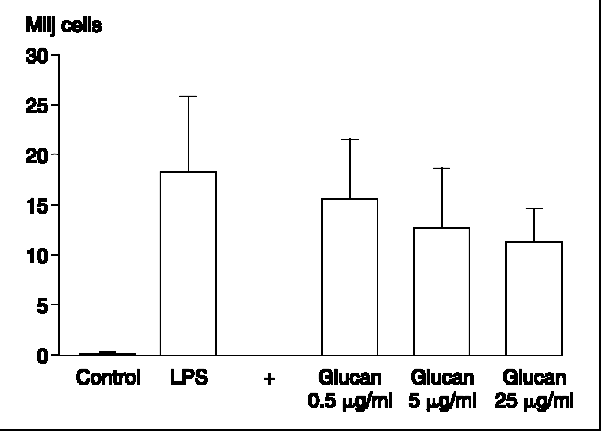
FIG. 1. Lung lavage neutrophils ( ´ 10 6 /g lung) 24 h after 40 min of exposure to endotoxin (LPS, lipopolysaccharide) and 4 h of expo- sure to curdlan at different